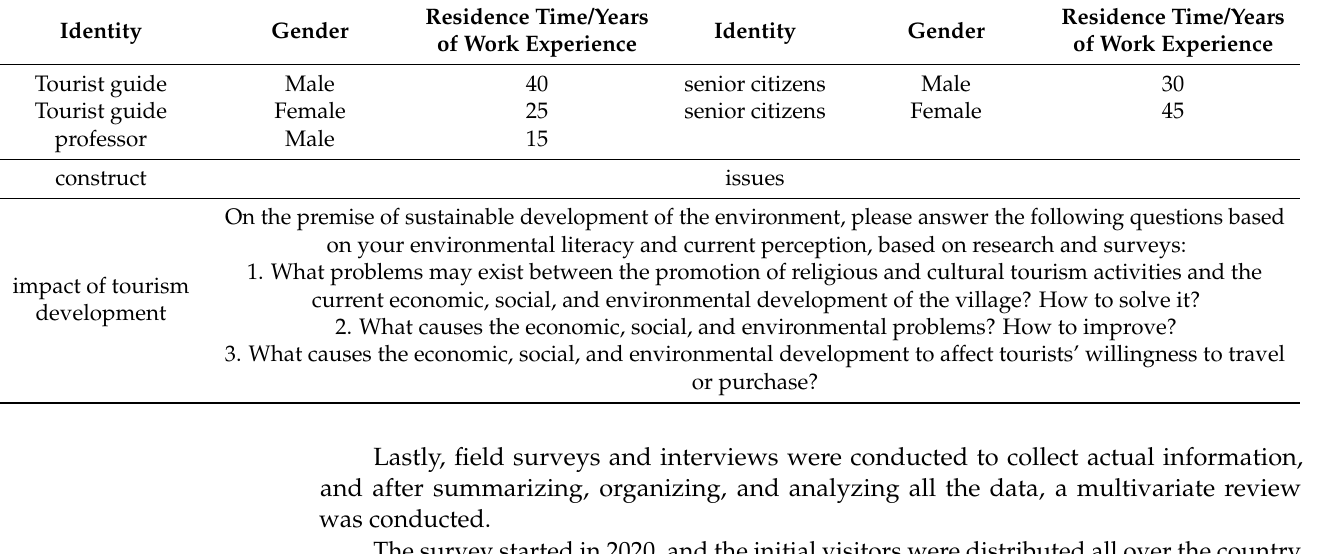
Table 2. Background information of the interviewees and outline of the